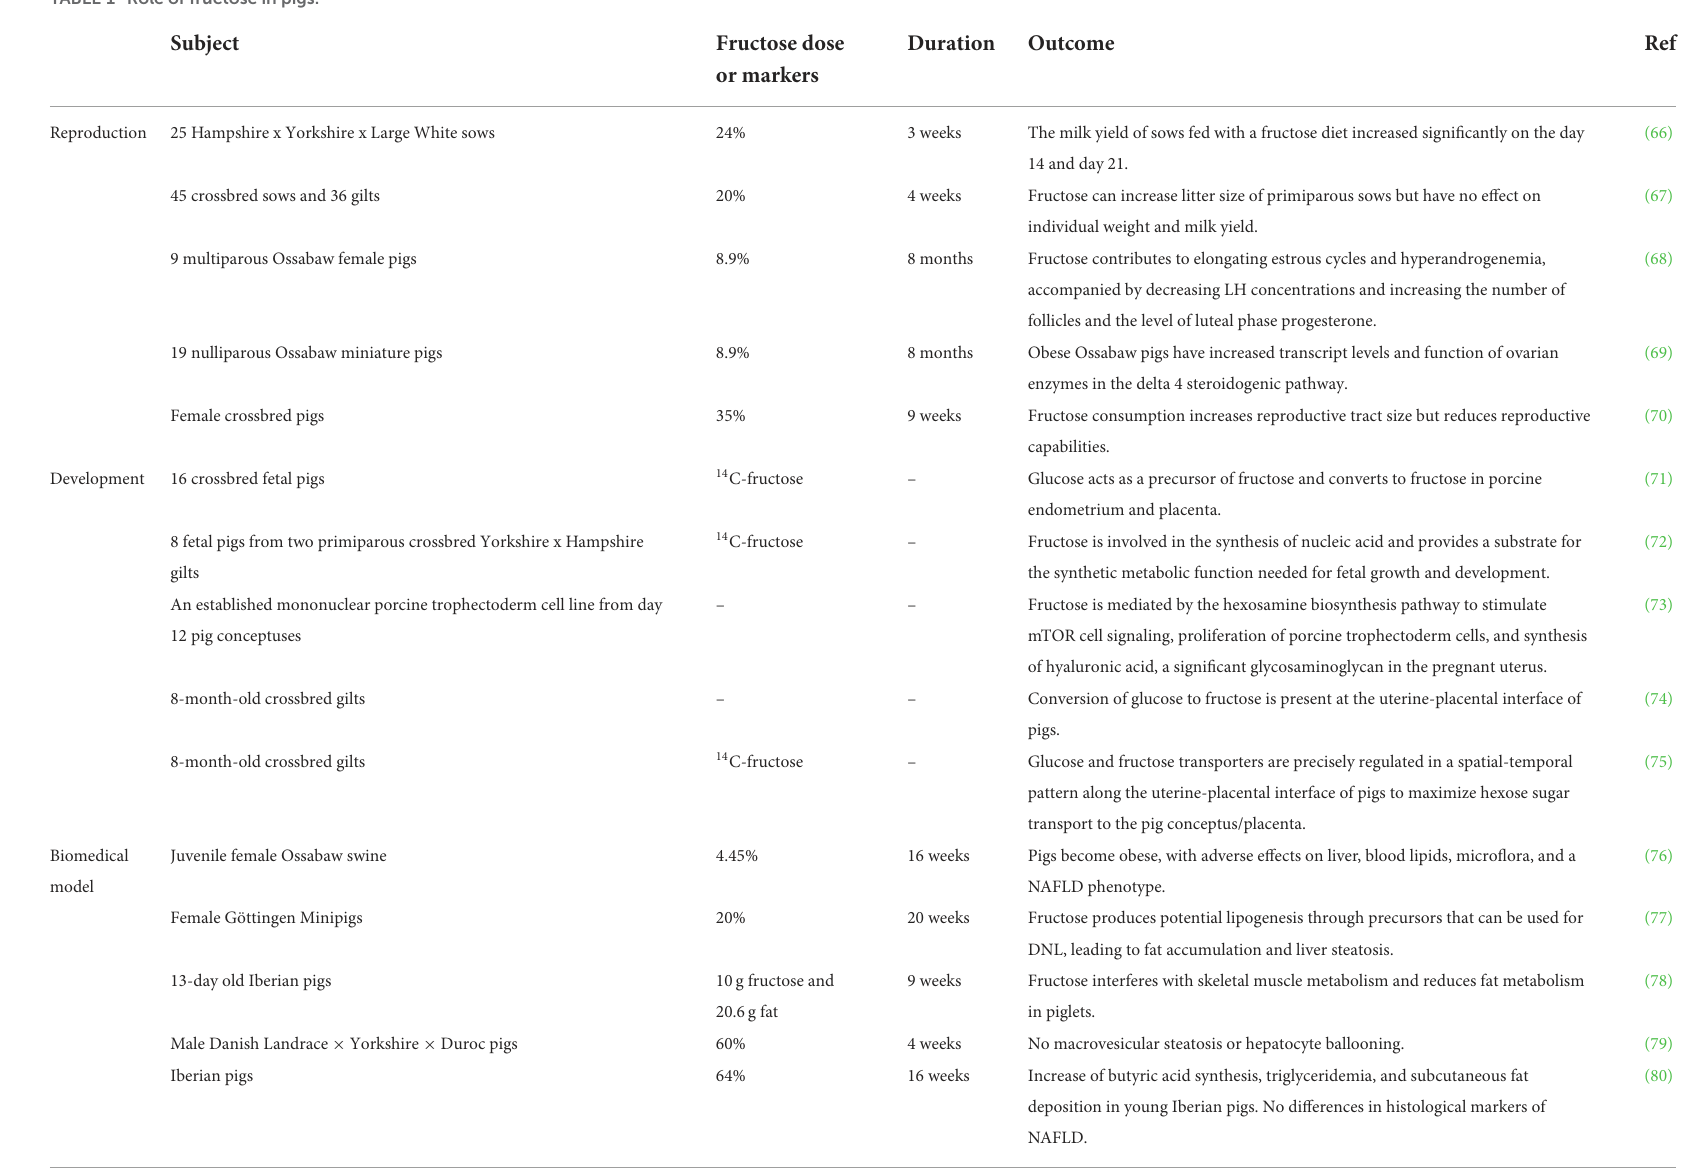
TABLE 1 Role of fructose in